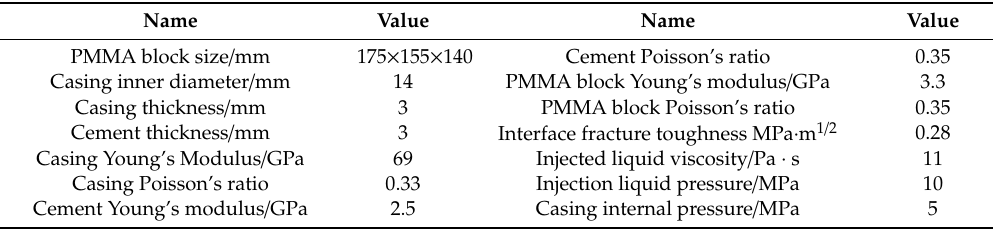
Table 4. Main parameters of the Brice